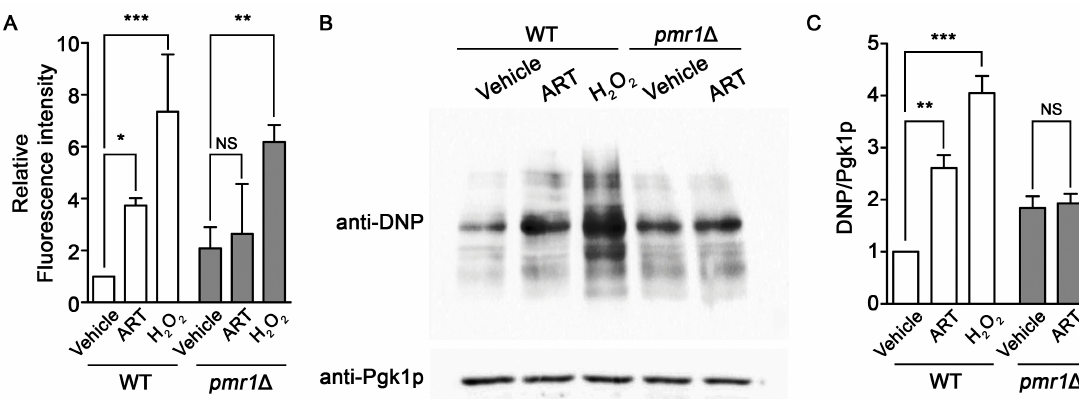
Figure 6. Yeast pmr1 ∆ mutants exhibit increased basal intracellular ROS and protein oxidation, which is not elevated following artemisinin exposure. WT and pmr1 ∆ cells were cultured in SCG media with vehicle or 10 μ M artemisinin for 24 h. ( A ) ROS levels were monitored using DCFH-DA. The fluorescence intensity of the samples was normalized to protein content with levels set to WT = 1. Results are from two independent experiments; values are the mean + SD. Differences between strains were analyzed using the two-tailed unpaired Student’s t -test; *** P < 0.001. ( B ) Protein carbonyls from the oxidation of protein side chains were monitored in whole cell lysates following derivatization with DNPH (2,4-dinitrophenylhydrazine). DNP-adducts were detected by immunoblotting with an anti-DNP antibody (upper panel) and the cytosolic protein Pgk1p (lower panel) was monitored as a loading control. ( C ) Quantitation of protein carbonylation results are normalized to the intensity of Pgk1p with levels normalized to WT = 1. Values are mean + SD ( n = 2). * P > 0.05, ** P > 0.01, ***P < 0.001, determined using Student’s t -test.